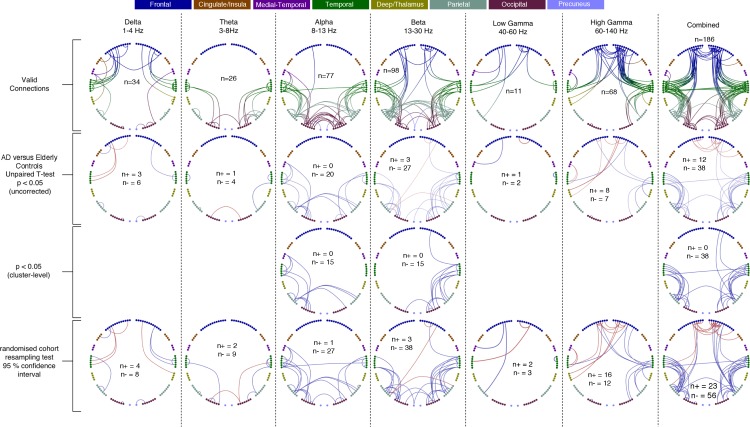
Each column shows oscillatory amplitude correlations comparing AD patients and matched elderly controls for each of the six frequency ranges where valid edges were found, and combined across frequency, and the Combined map.The top row shows where there are ‘valid’ edge connections in either of the two groups. Colours, with a key at the top of the figure, indicate regions of brain areas that the connections originate from. The numbers on the plots show the number of valid edges found. The second row shows the unpaired t-statistic for AD compared to controls - Increases are displayed in red and decreases in blue and only those connections significant at p<0.05 (uncorrected) are shown. The numbers on each plot (n+/n-) show the number of significant increases and decreases found in each map. In terms of corrected significance only one connection each reached the p<0.05 threshold in Beta, High-Gamma and Combined (not shown). Using the cluster-level network-based size statistic, shown in the third row, significantly large clusters were found for the Delta, Alpha, Beta and Combined maps. The bottom row shows the results of the cohort random sampling analysis. Edges are only shown if they are within the 95% confidence limit for AD-related increases (red) or decreases (blue). Note that, in general, the predominant effect is for edges to show decreases in connectivity in AD patients, compared to controls, and that this is most clearly shown in the Combined map (right-hand column), in which the most valid connections are identified and the most significant, and consistent, differences are seen. Data and scripts needed to generate this figure can be found at http://dx.doi.org/10.17605/OSF.IO/E4CJX.